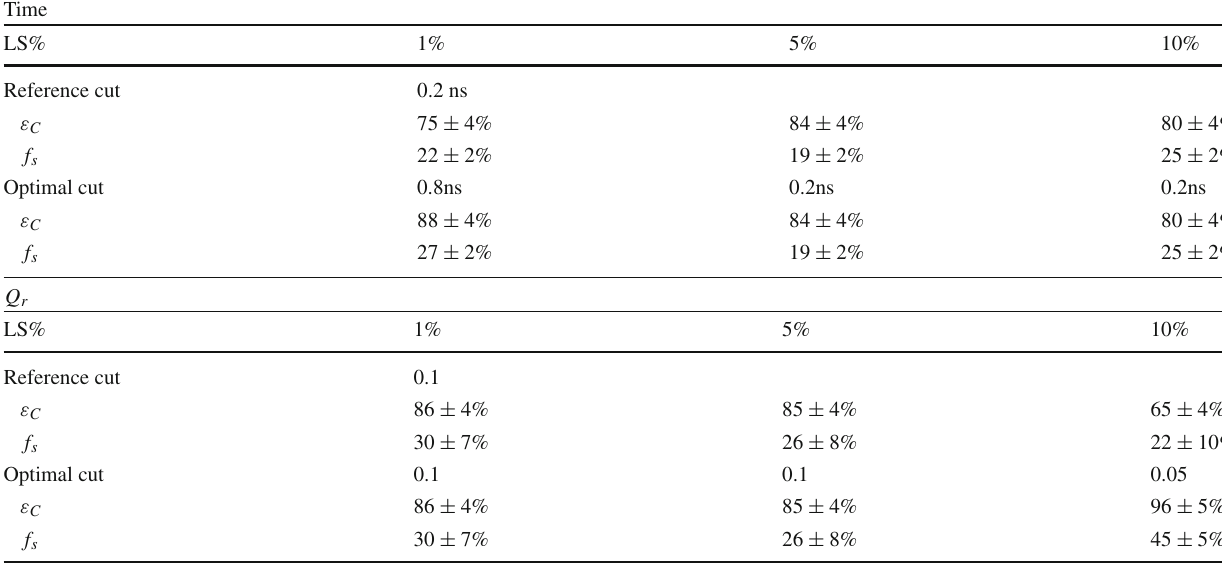
Table 3 Results of Cherenkov and scintillation separation for cosmic muons and the three different versions of WbLS for the time residual (top) and Q r (bottom) methods. Values for the Cherenkov detection